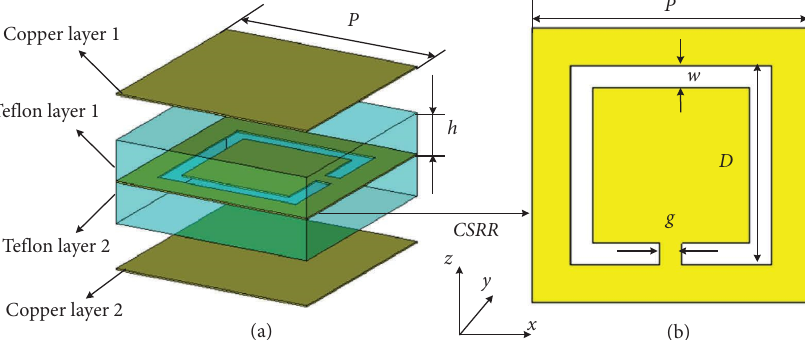
Figure 2: Structure of the decoupling unit. (a) WCSRR unit cell compositional structure. (b) CSRR